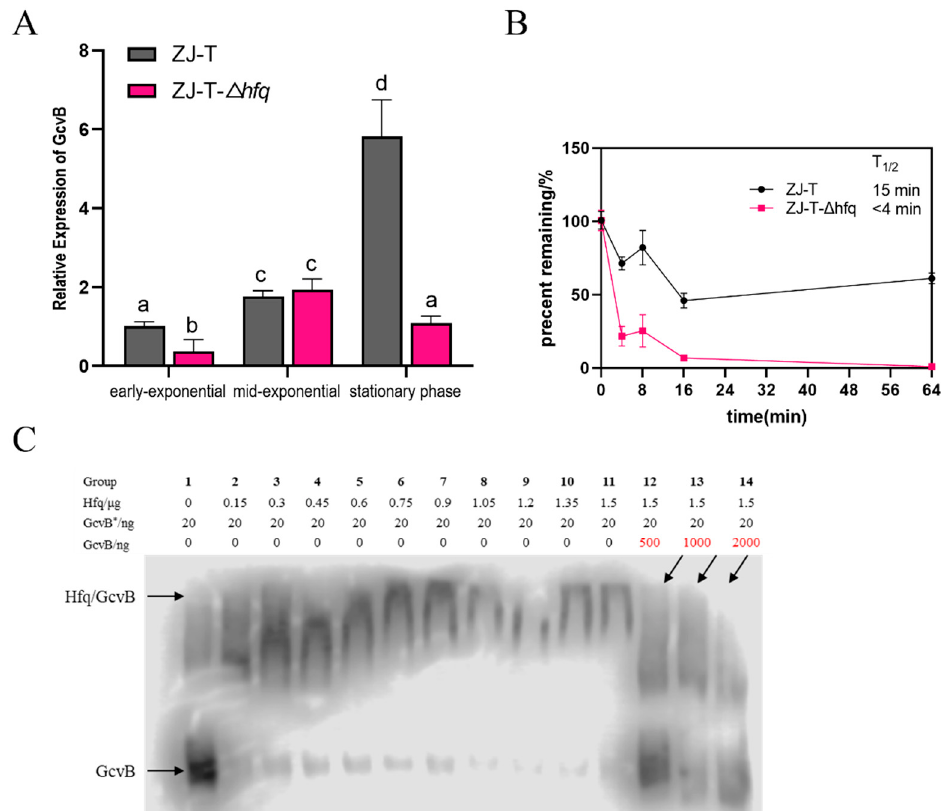
Figure 10. Effects of Hfq on GcvB. ( A ) Relative expression of GcvB at different periods of wildtype and hfq deletion strains. ( B ) Stability measurements of GcvB in hfq mutant strains. The half ‐ life of GcvB is about 15 min in wild strain ZJ ‐ T, but it is shortened to no more than 4 min in hfq deletion strain. ( C ) The Hfq protein binds specifically to GcvB. The picture shows the binding of GcvB to protein Hfq detected by RNA ‐ EMSA. The Hfq protein was continuously added from 0 μ g (group 1) to 1.5 μ g (group 11). When the concentration of Hfq protein reached 1.05 μ g (group 8), the binding of GcvB had reached saturation. After the addition of the non ‐ biotinylated GcvB probe (groups 12, 13, 14), the biotinylated GcvB* was competitively eluted.